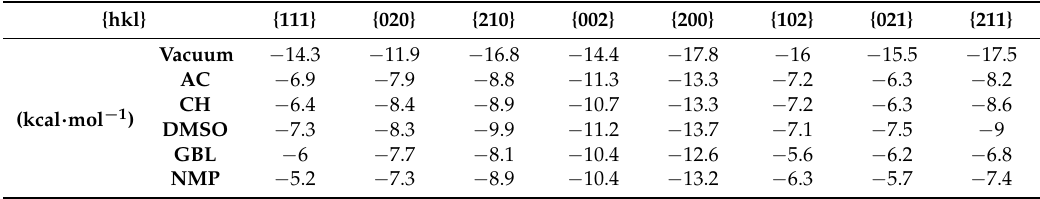
Table 3. The (cid:1831) (cid:2911)(cid:2930)(cid:2930)(cid:2929) and area ratio of each face of RDX in selected solvents. Table 3. The E s att and area ratio of each face of RDX in selected solvents.